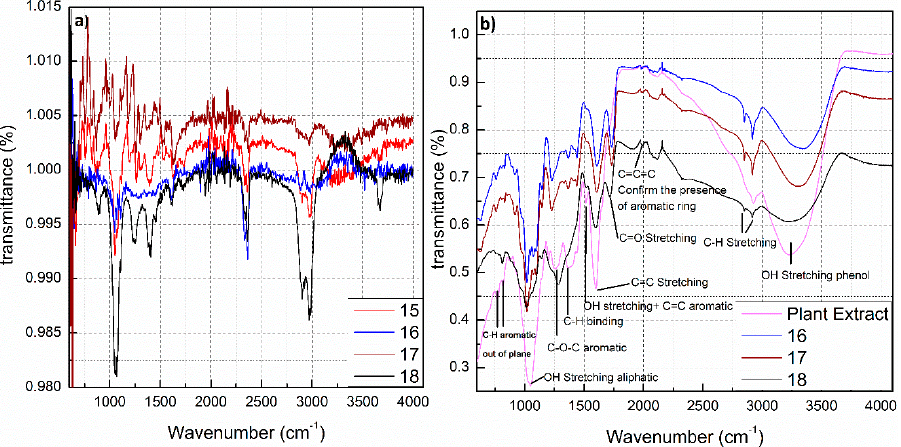
Figure 4. ATR spectra of AgNPs synthesized with St John’s wort extract obtained using a Bruker FTIR Vertex 80 v spec- trometer apparatus, ( a ) without vacuum and ( b ) with vacuum. FTIR Vertex 80 v spectrometer apparatus, ( a ) without vacuum and ( b ) with vacuum.